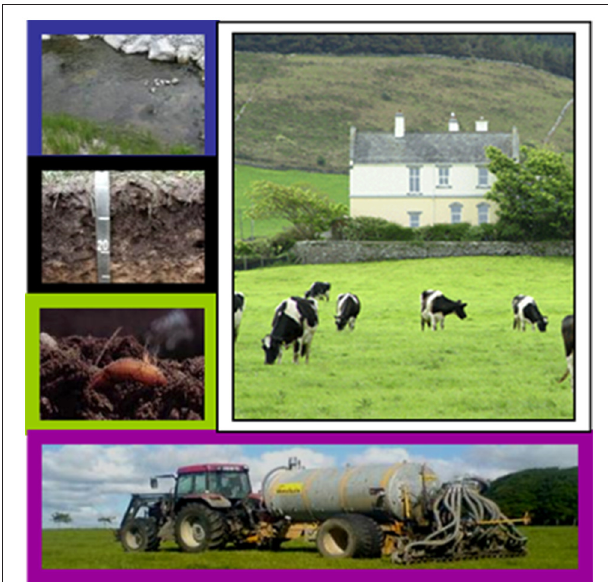
FIGURE 1 | Illustrative representation of the suite of five soil functions proposed by Schulte et al. (2014). The white box indicates primary production; blue, water purification and regulation; black, carbon storage and regulation; green, provision of a habitat for biodiversity; purple, cycling of